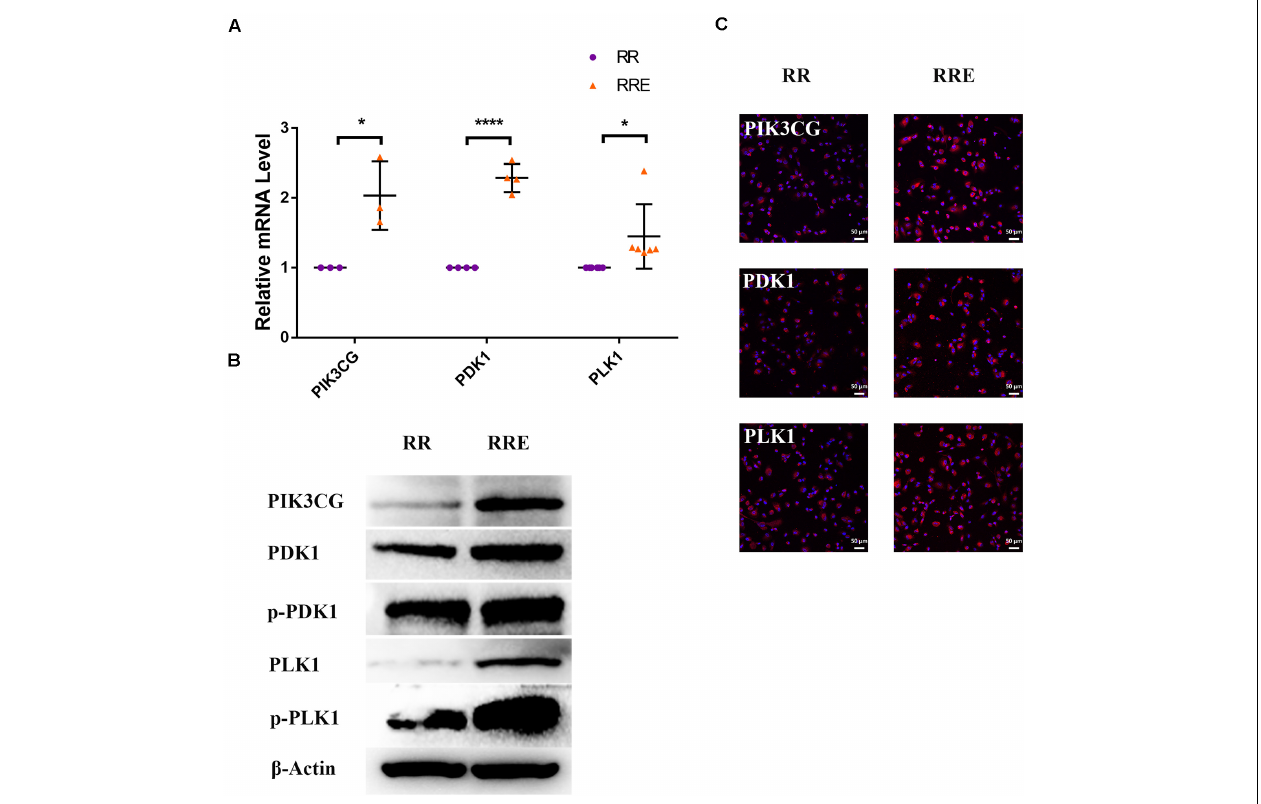
FIGURE 10 | The cocultured ESCs upregulated PI3K pathway-related markers of replicative senescent RPE cells. (A) Expression of PI3K pathway-related markers in the RR and RRE groups, as assessed by RT-qPCR ( n ≥ 3 biological repeats). (B) Results from PI3K pathway-related markers in the RR and RRE groups as determined by western blotting. β -Actin was used as the internal reference. (C) The expression levels of PI3K pathway-related markers in the RR and RRE groups as determined by immunofluorescent staining. Scale bar, 50 µ m. Data are presented as the mean ± SD. ∗ P < 0.05; ∗∗∗∗ P <